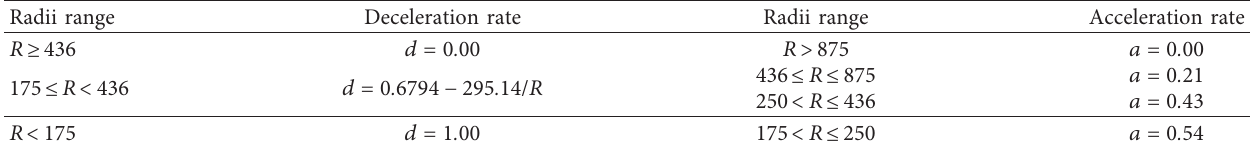
Table 2: Acceleration and deceleration